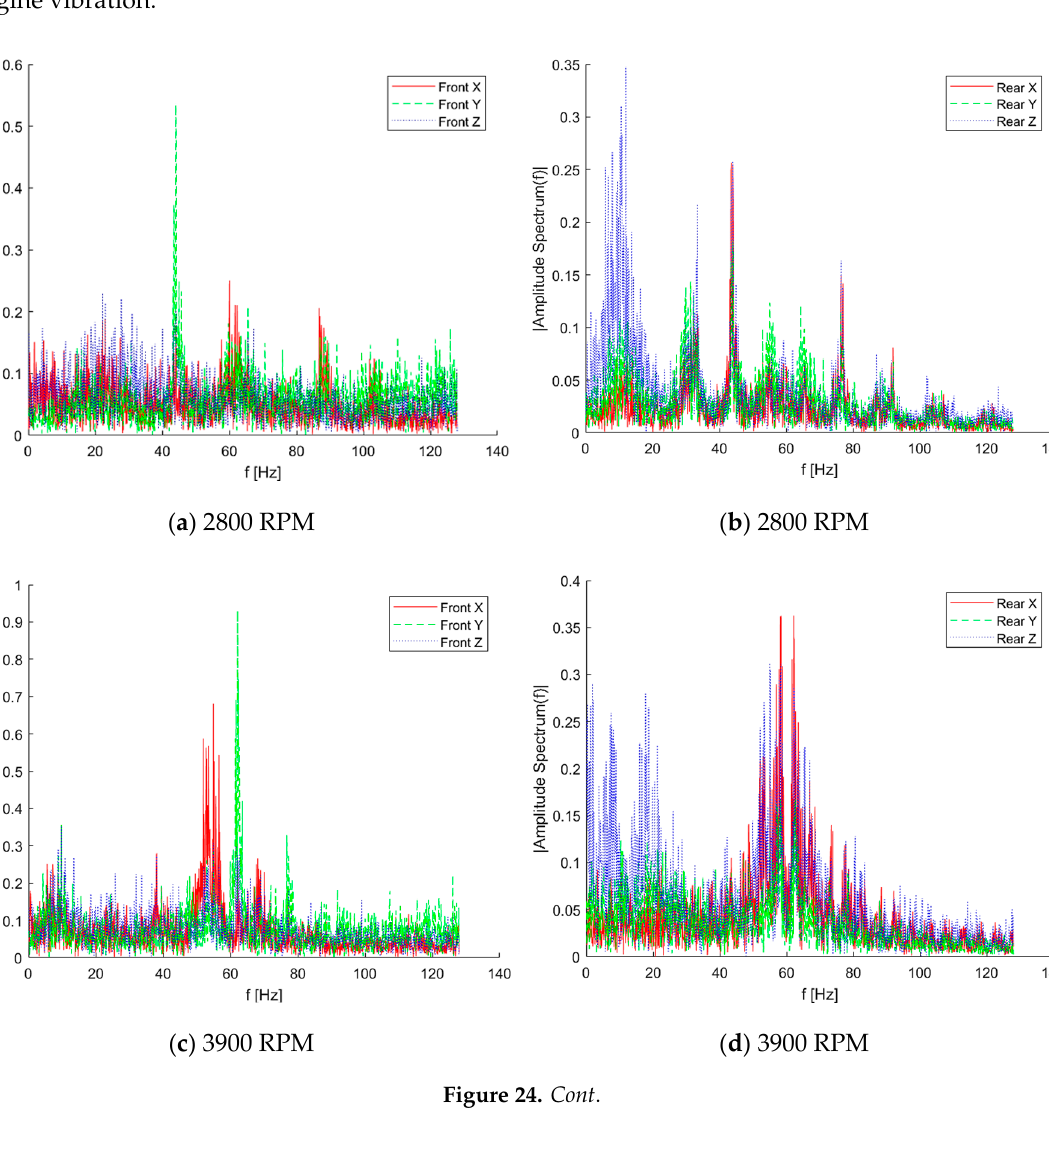
Figure 23. Max/ median /min values during engine test for ( a ) strain sensors, and ( b ) accelerometers.